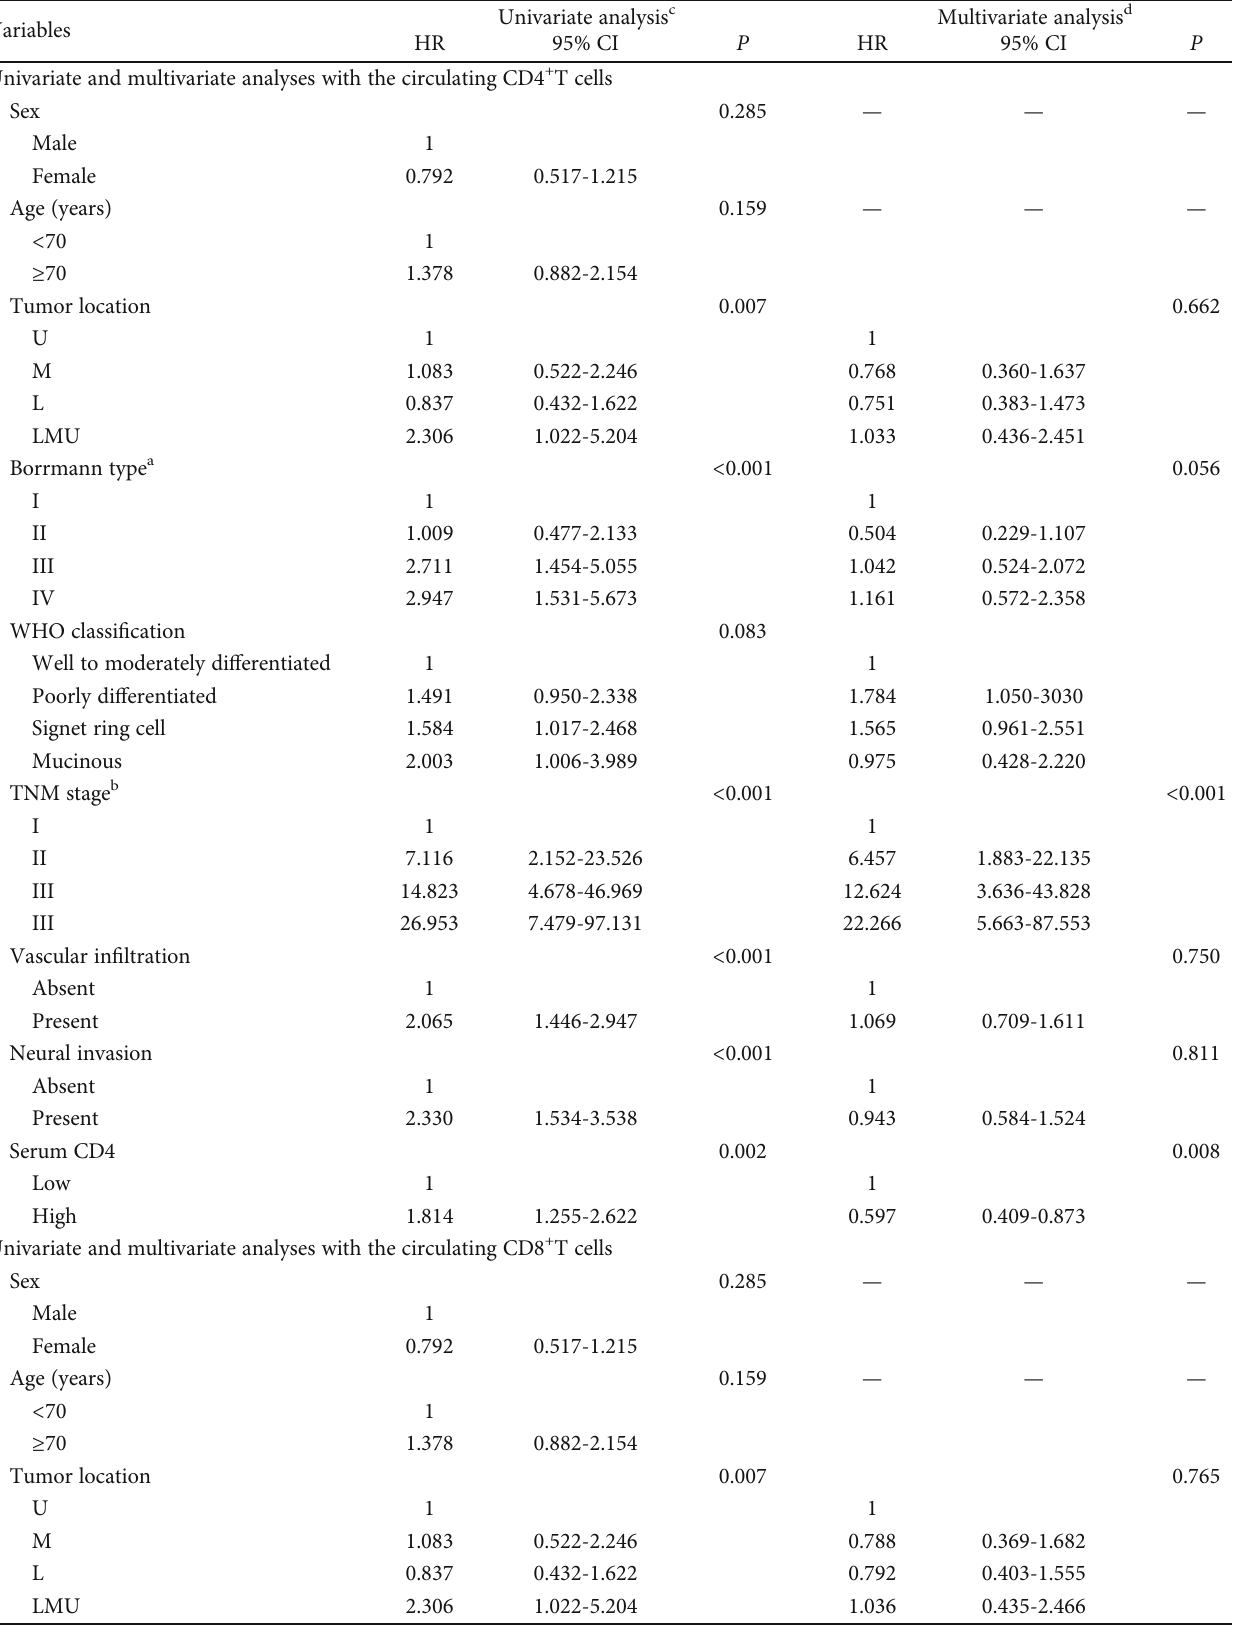
Table 3: Univariate and multivariate analyses of independent risk factors for death of patients with